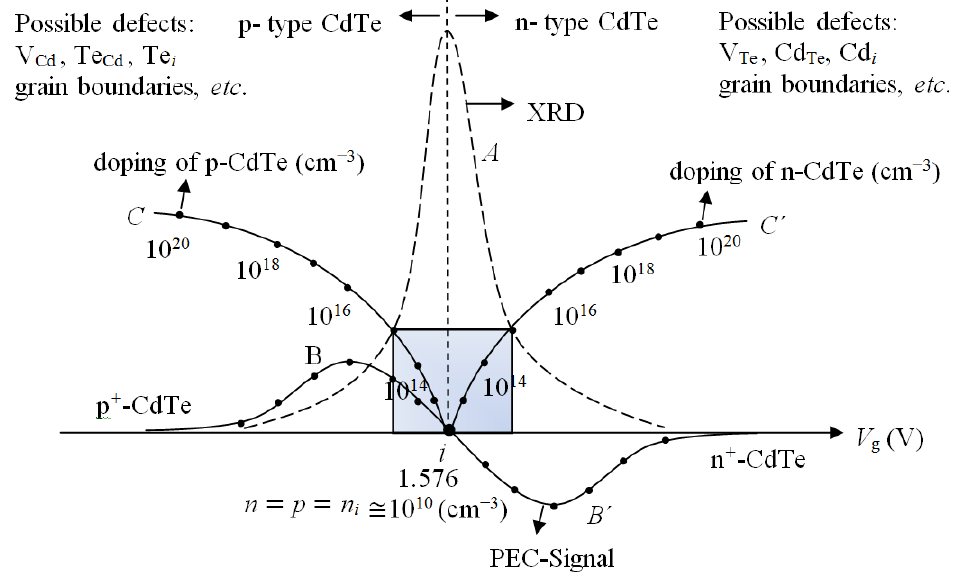
Figure 18. Graphical presentation of the summary of results for electrodeposited CdTe layers. The inversion point, i at V = 1.576 V produces stoichiometric and highly g crystalline CdTe. The variation of electrical conduction type and doping concentration are shown by the curves BiB' and CiC' respectively. Electronic device quality materials can be grown in the shaded region and possible native defects in both p- and n-CdTe layers are also indicated on the two main